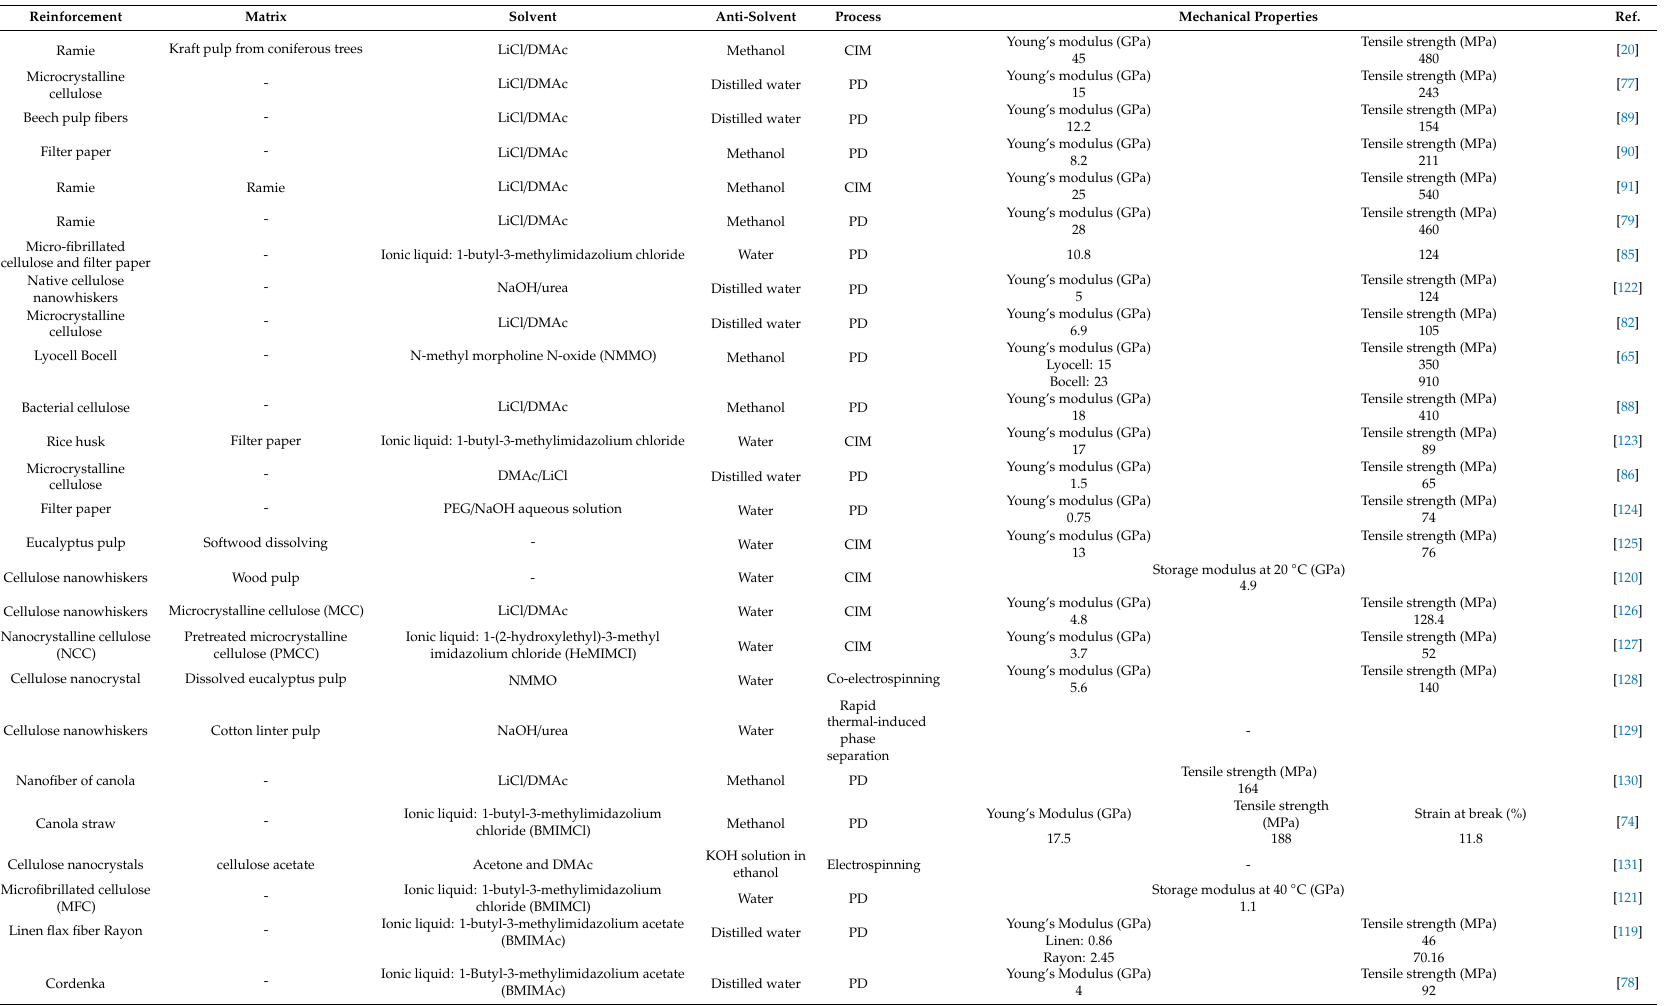
Table 2. Literature review on precedents of ACC